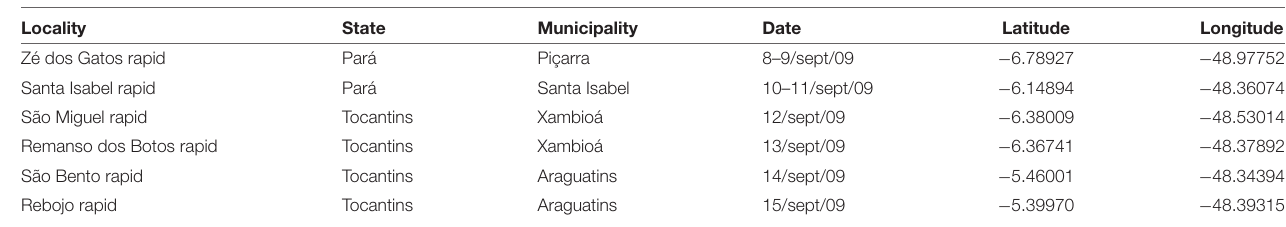
TABLE 1 | Location of sampled rapids in the Araguaia